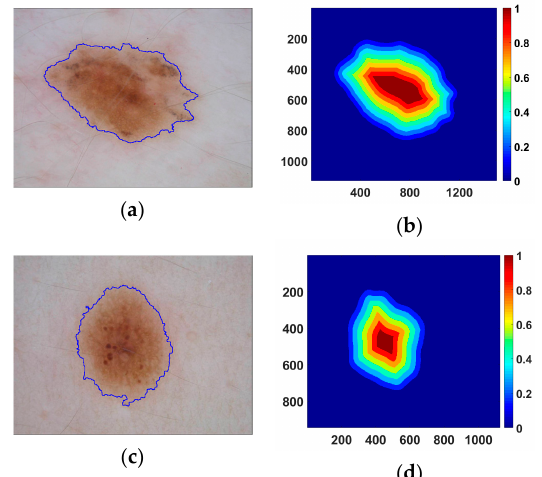
Figure 4. Examples of skin lesion images with outlines (blue) and distance maps. The first column ( a , c ) shows the original lesion images and the second ( b , d ) shows the corresponding distance maps. The scales for the original lesion images are about 1300 pixels × 1000 pixels and 1000 pixels × 800 pixels, respectively. The numbers of image size of distance maps are measured by pixels. The numbers in color-bar represent corresponding weights.